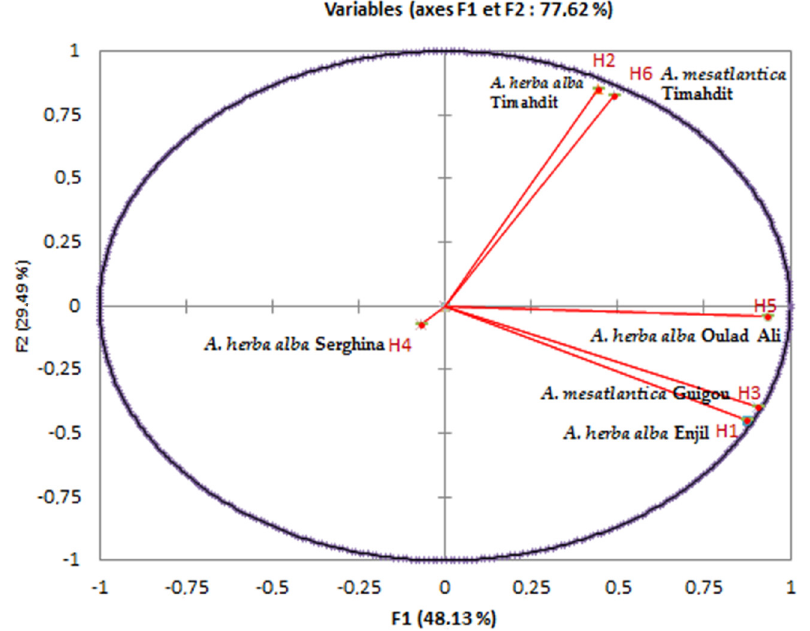
Figure 6. Principal component analysis for the EO of the six samples from the different regions studied.